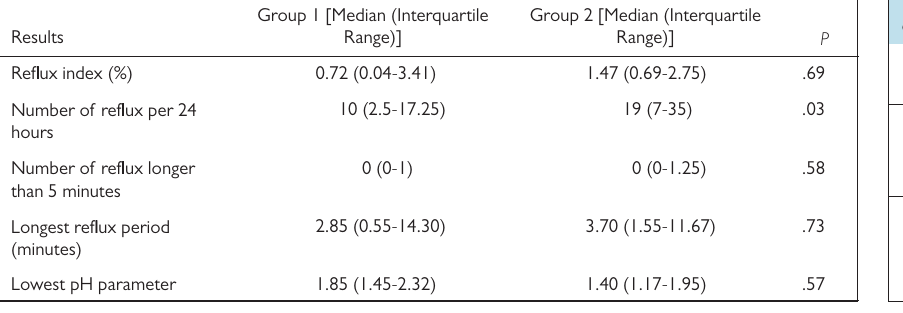
Table 3. Comparison of the Results of MII-pH Monitoring Parameters of the 2 Groups Results